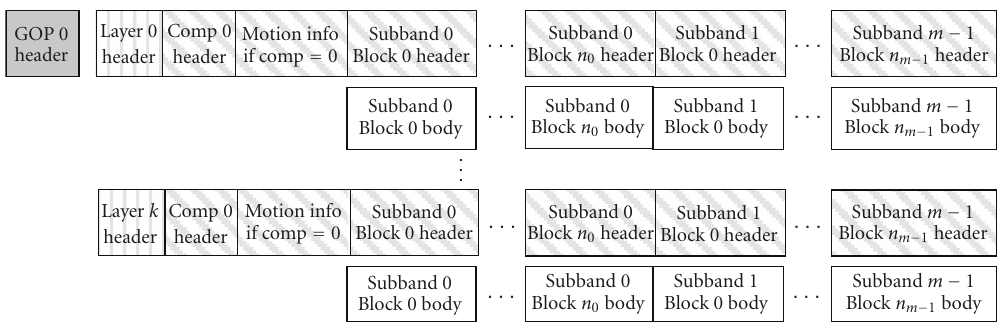
Figure 5: MSRA wavelet bitstream format (please note that there is no need to enforce layer structure for MCTF-based wavelet bitstreams).